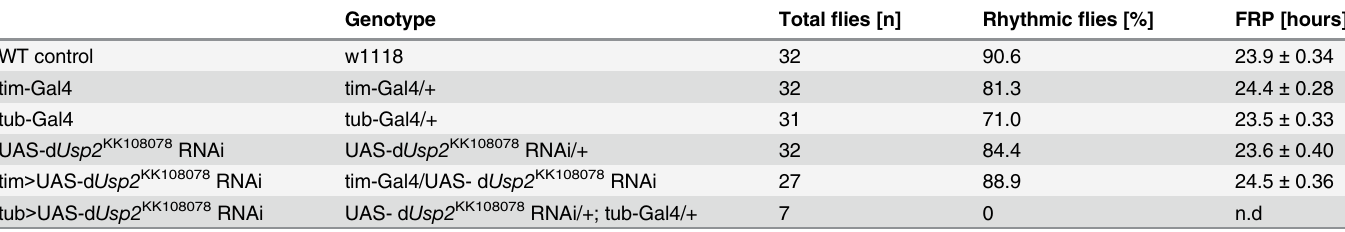
Table 1. Inactivation of CG14619 in Drosophila does not affect circadian free-running period. Adult flies lacking CG14619 in the whole body (tub > UAS CG14619 KK108078 RNAi) or only in clock neurons (tim > UAS CG14619 KK108078 RNAi) and their respective controls were entrained for 3 days in LD at 25°C before being released in constant darkness (DD) for 10 days for calculation of their free-running period. Data are presented as mean ± SD of the indicated number of individuals.